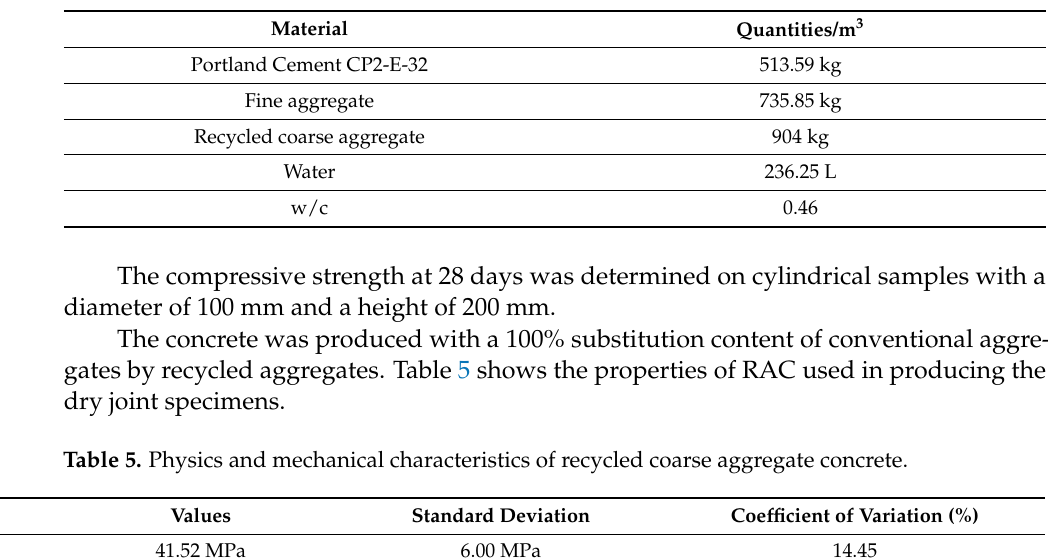
Table 4. Concrete mixing ratios.